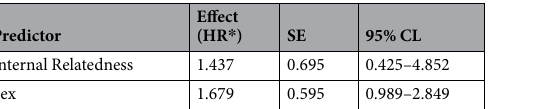
Table 4. Cox proportional hazard model results on the effect of internal relatedness (IR) and survival in the Tasmanian devil. * HR; Hazard rate (see methods for